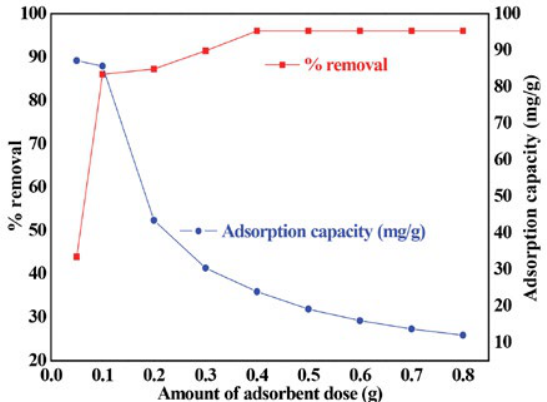
Figure 3 . Influence of pH on the 2,4,6-trichlorophenol biosorption onto PBP. Experimental conditions: Temp = 25 ± 1 °C, adsorbent mass = 0.1g, initial concentrations = 100 mg/L, agitation rate = 220 rpm, contact time = 2h.